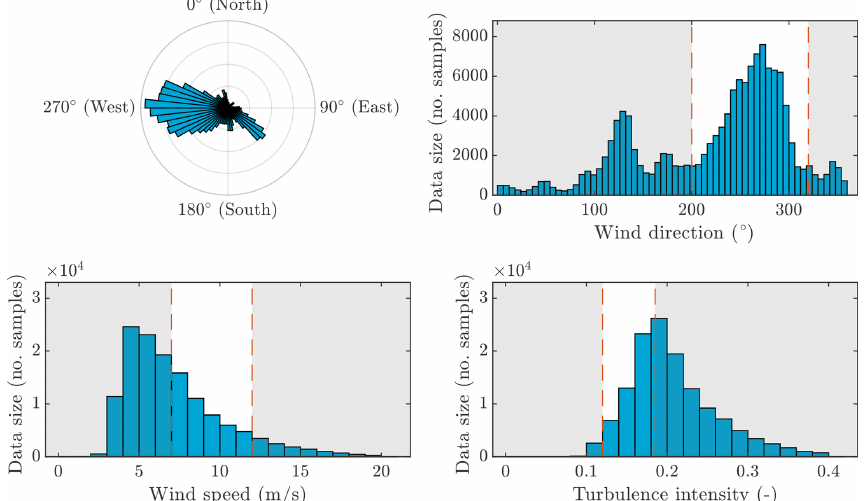
Figure 2. All measured data from 19 August 2019 until 3 February 2020, binned by wind direction, wind speed, and turbulence intensity. Wind comes predominantly from the west, which is within the scope of the wake-steering experiment. Furthermore, wind speeds are relatively low and turbulence intensities are high. The gray area covers data that are discarded in analysis of the wake-steering experiments.